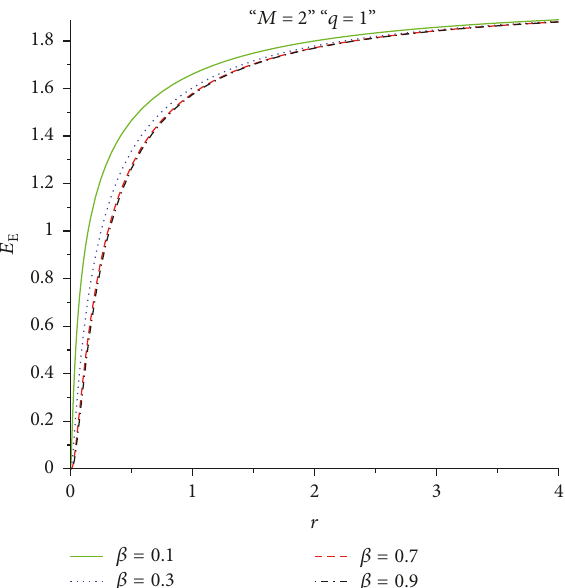
Figure 1: Energy distribution obtained in the Einstein prescription for different values of 𝛽